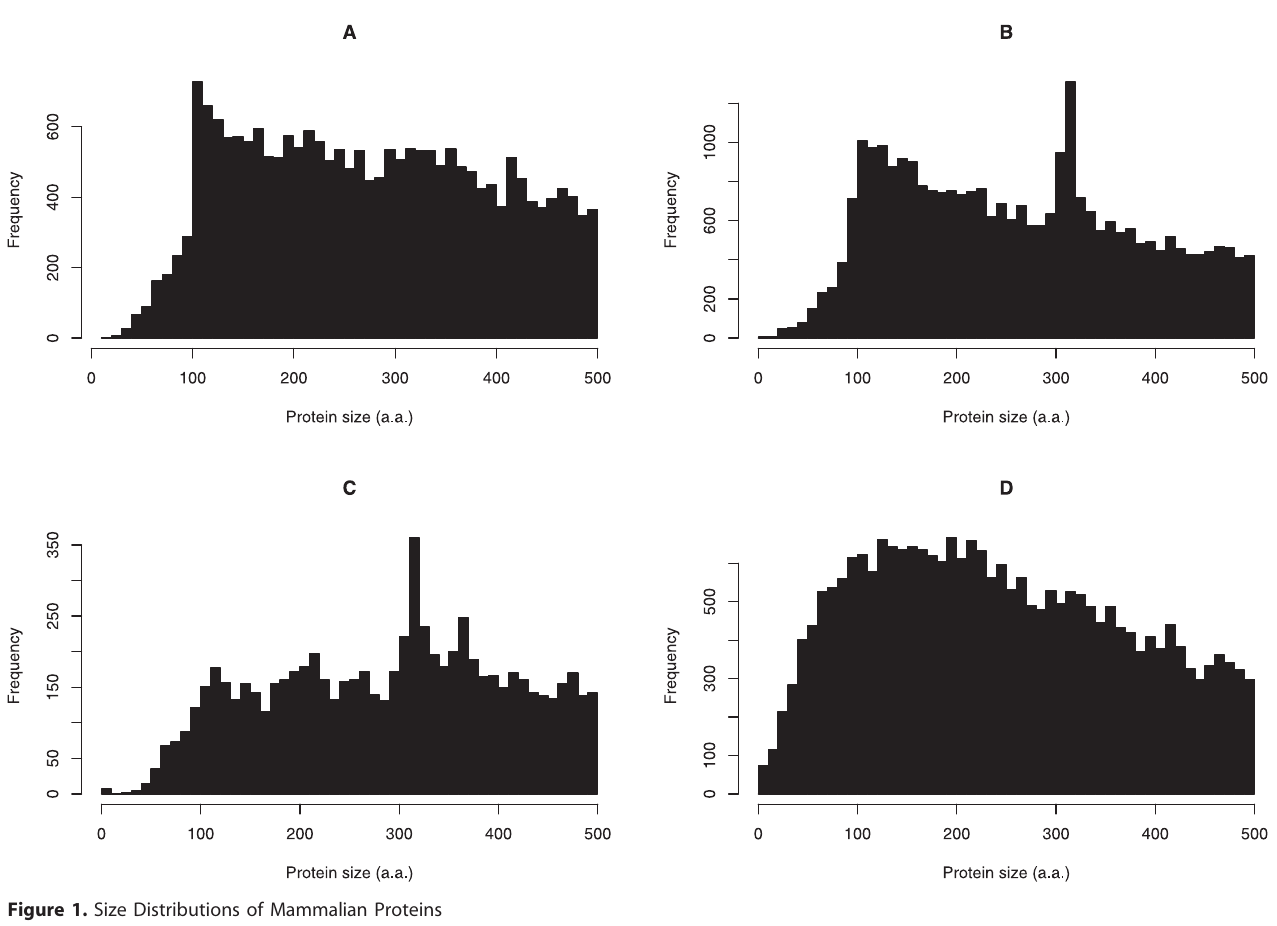
Figure 1. Size Distributions of Mammalian Proteins (A) For 29,991 full-length mouse proteins from the FANTOM annotations. (B) For 40,865 mouse proteins from the IPI database. (C) For 11,679 human proteins from Swiss-Prot. (D) For 31,035 mouse proteins predicted in the FANTOM cDNAs using CRITICA. DOI: 10.1371/journal.pgen.0020052.g001